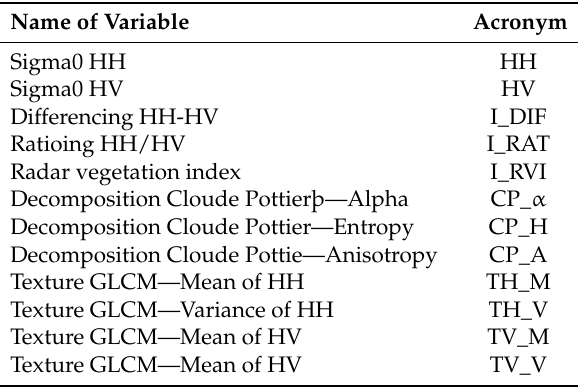
Table 3. Variables for assessing variable